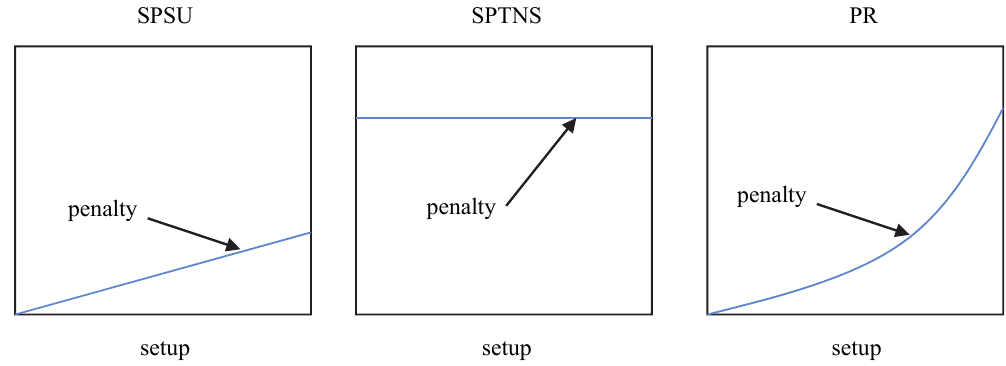
Fig. 9. Examples of functions for penalizing setups employed by SPSU, SPTNS, and